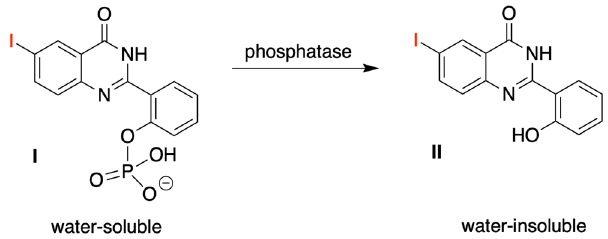
Figure 1. Quinazolinyl–phosphoester cleavage.